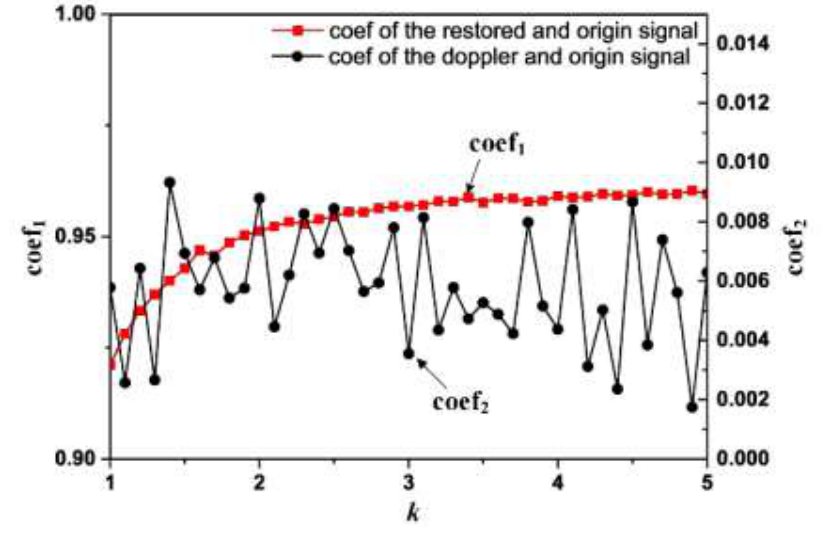
Figure 10. The relationships between k and coef 1 , coef 2 ,